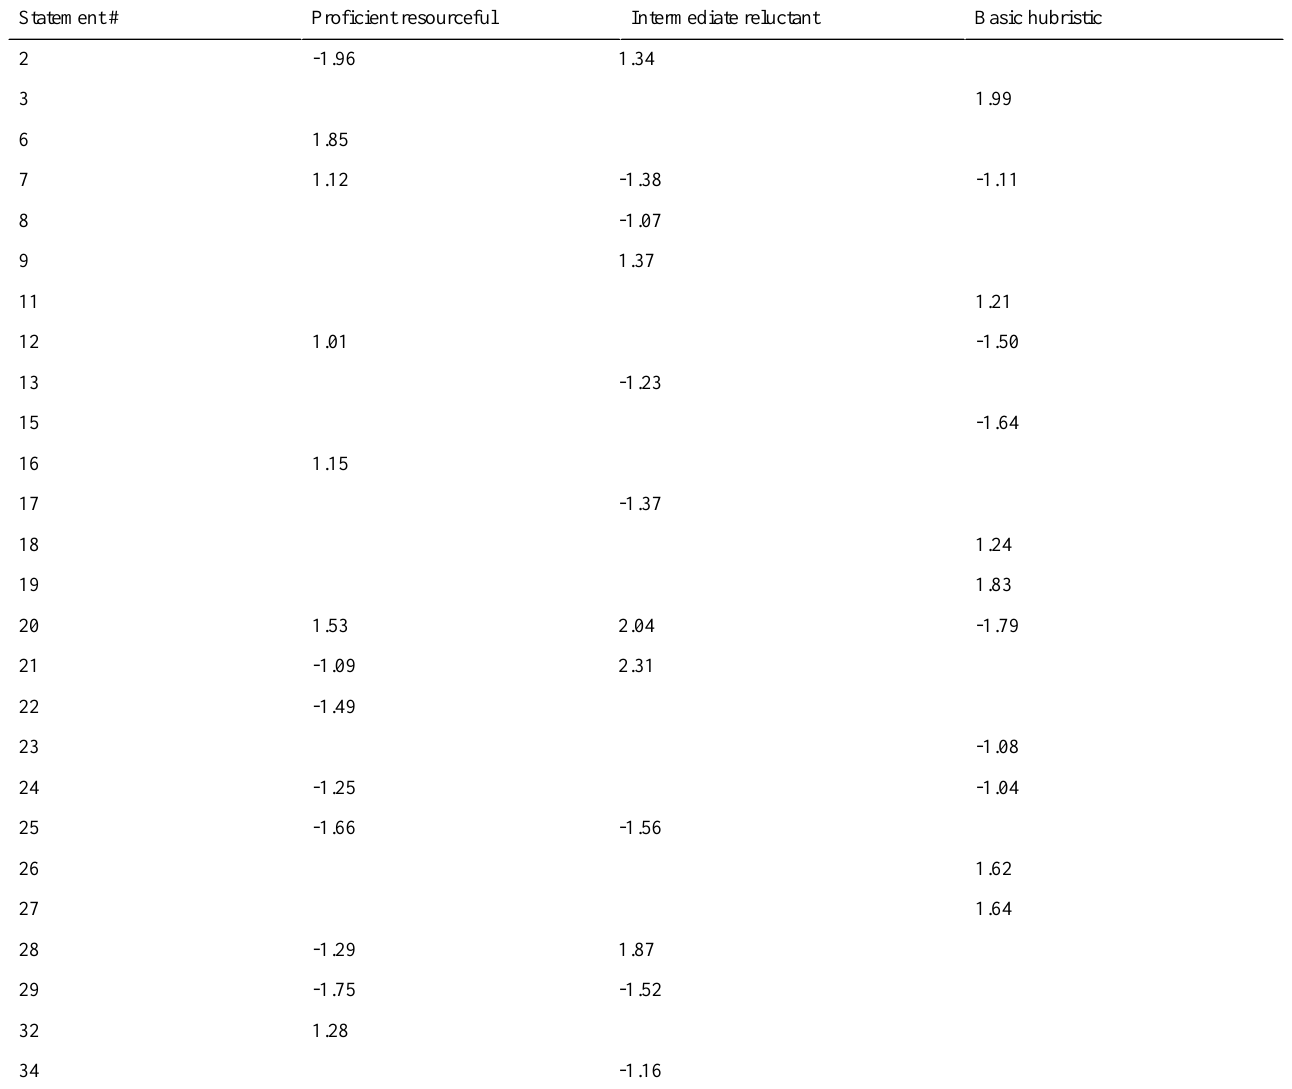
Table 4. Salient statements for retained factors less than –1 and greater than +1. a